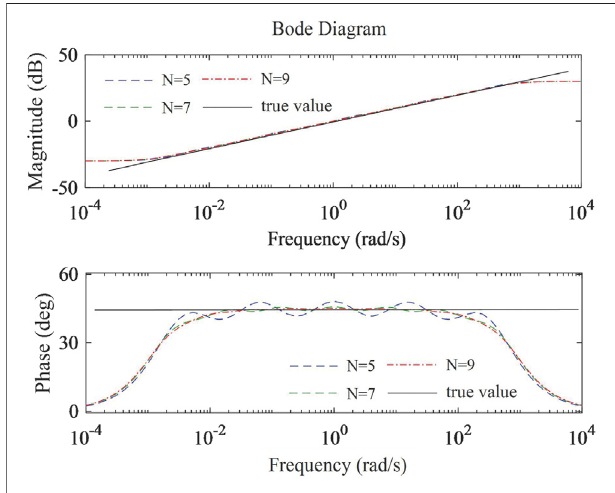
FIGURE 4 | Frequency response